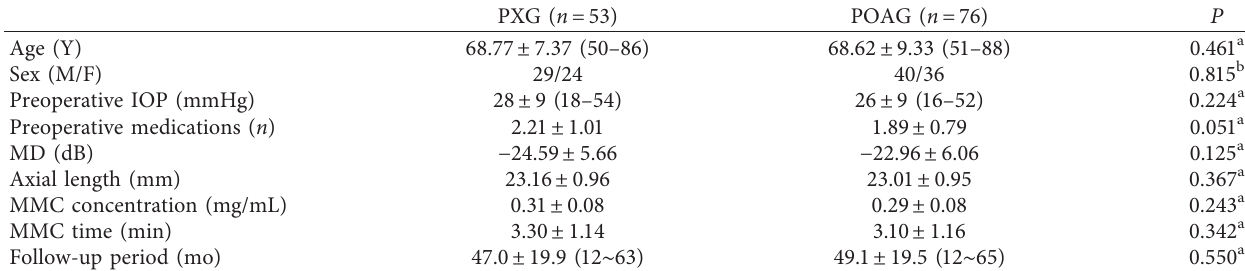
Table 1: General information for glaucoma patients in the two